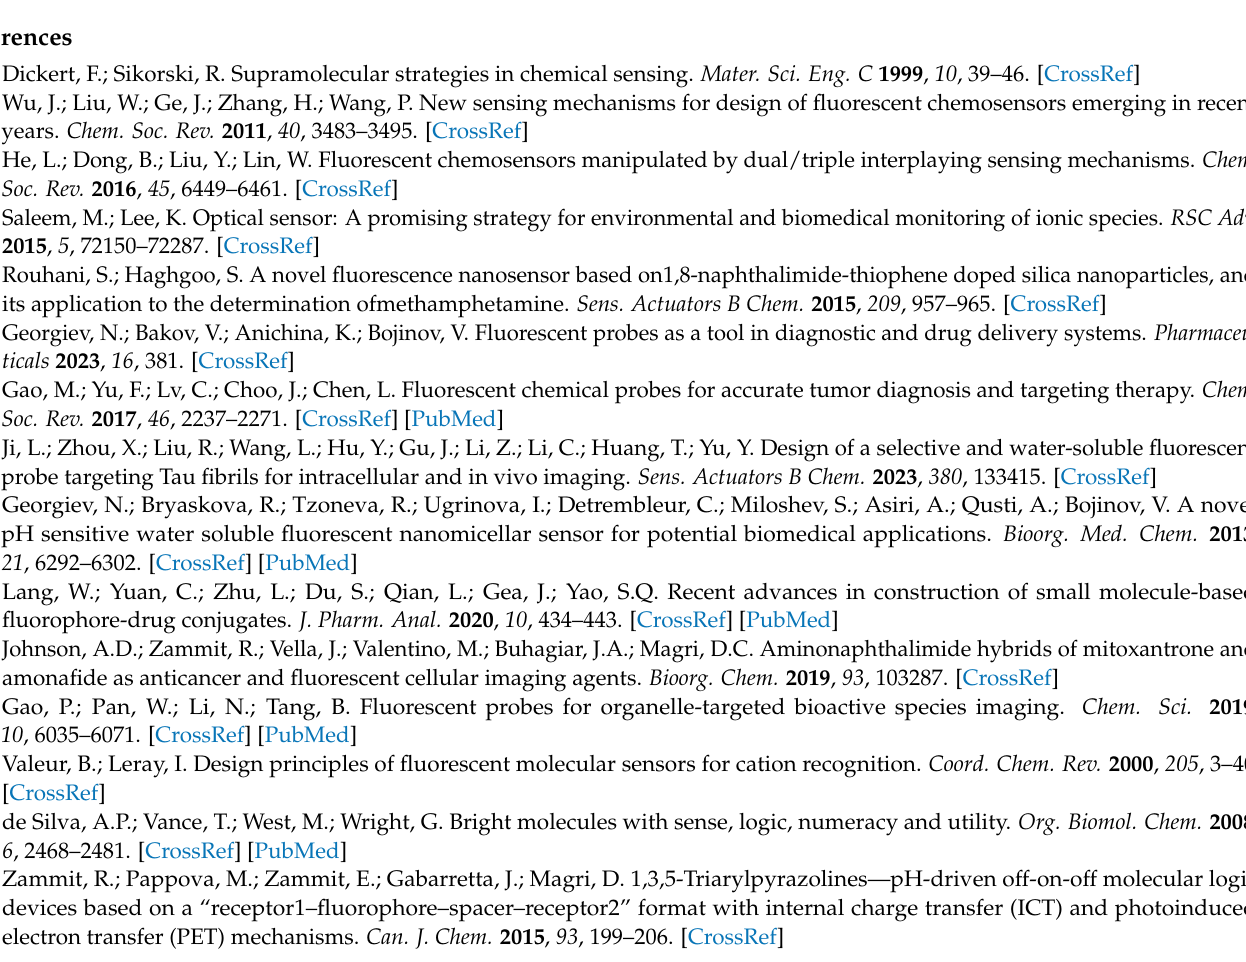
3 ; Figure S5: IR spectrum of dyad 5 ; Figure S6: 1 H NMR Spectrum of dyad 5 ; Figure S7: 13 C NMR Spectrum of dyad 5 ; Figure S8: 13 C NMR Spectrum of dyad 5 in a range of 164–138 ppm; Figure S9: 13 C NMR Spectrum of dyad 5 in a range of 134–121 ppm; Figure S10 13 C NMR Spectrum of dyad 5 in a range of 122–105